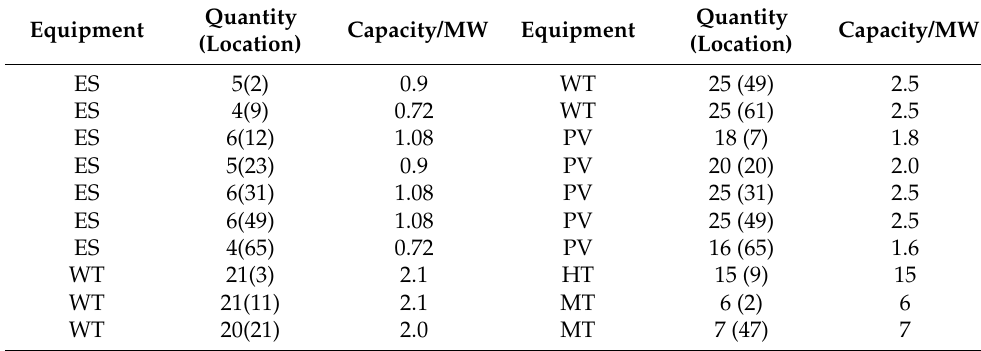
Table 5. PG&E69 NDN planning results considering GPCT and CET.